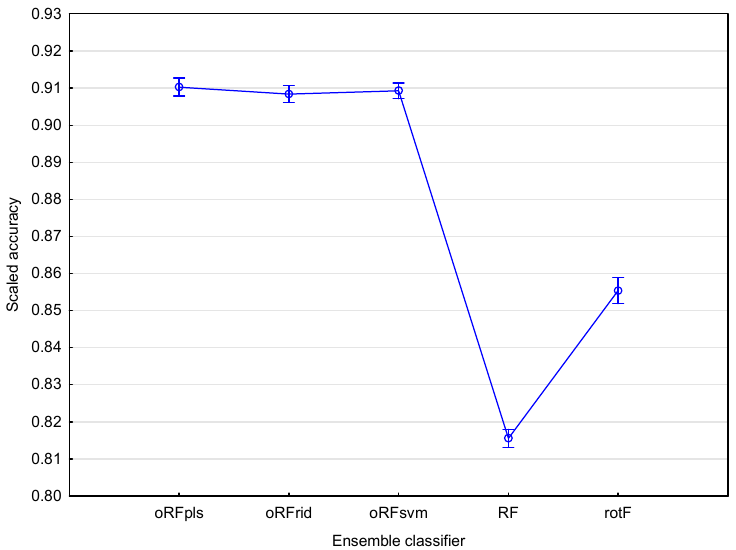
Figure 8. Mean classification accuracies using resampled hyperspectral bands ( n = 800) for each of the tree-based algorithms (RF = random forest; rotF = rotation forest; oRFridge = oblique random forest with ridge regression as splitting model; oRFpls = oblique random forest with PLS as splitting model; oRFsvm = oblique random forest with SVM as splitting model) considered in this study. The scaled accuracy is the classification accuracy represented on a scale ranging from zero to one. Vertical bars denote 0.95 confidence intervals.